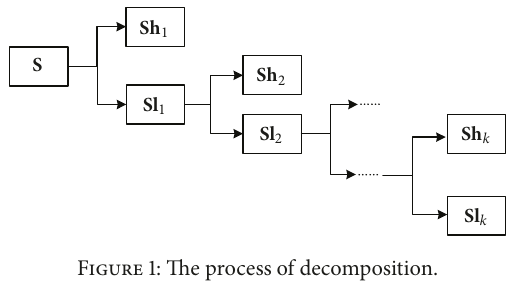
Figure 1: The process of decomposition.